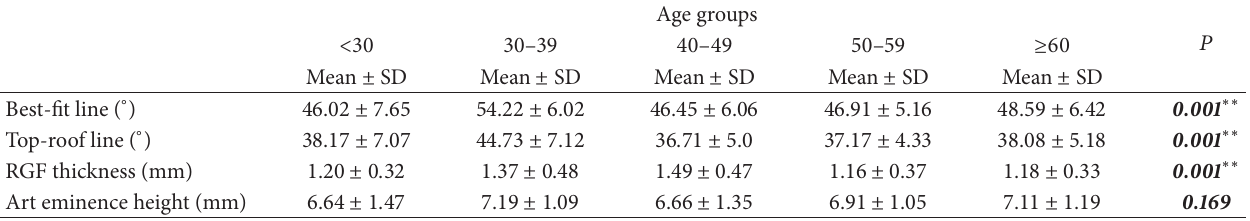
Table 3: The mean values of the articular eminence and roof of the glenoid fossa thickness according to sagittal condyle morphology. Sagittal condyle morphology With OA Without OA Flattened Osteophyte Erosion Best-fit line ( ∘ ) 48.50 ±